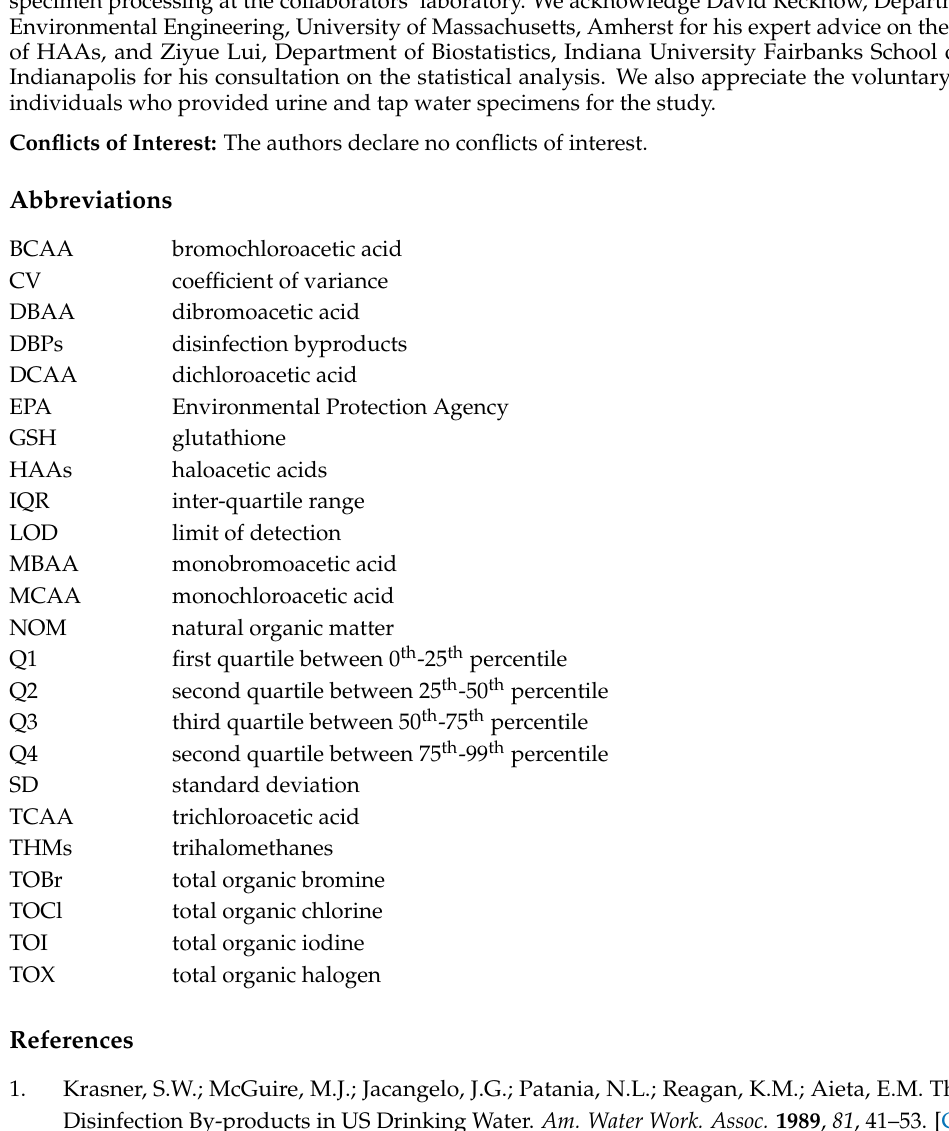
Table S1: Summary data on individual measurement of HAAs in urine and drinking water specimens, Table S2: Summary statistics of urinary MCAA and TCAA ( µ g/L) without data below limit of detection (LOD), Table S3: Intraday change in urinary MCAA and TCAA levels ( µ